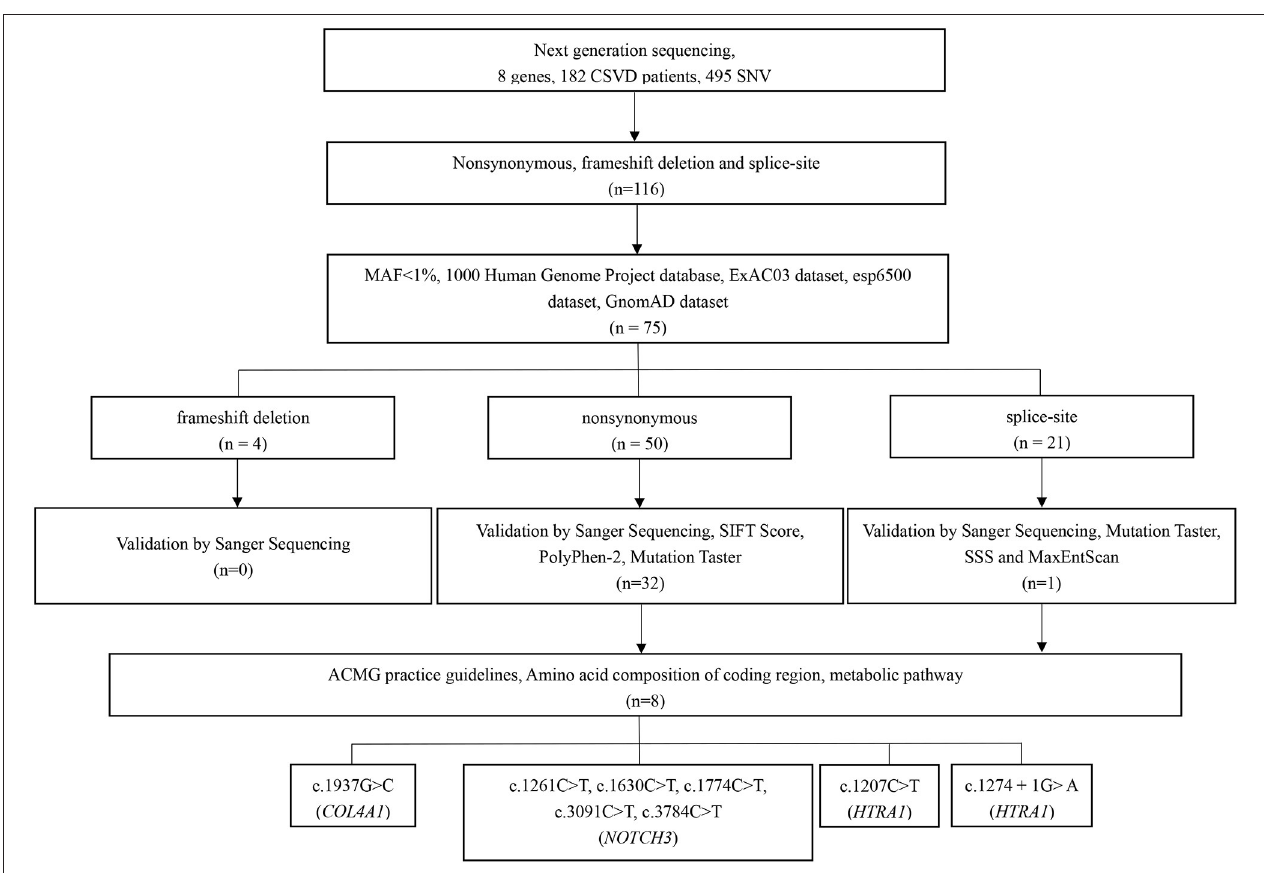
FIGURE 1 | Filtration process and the remaining